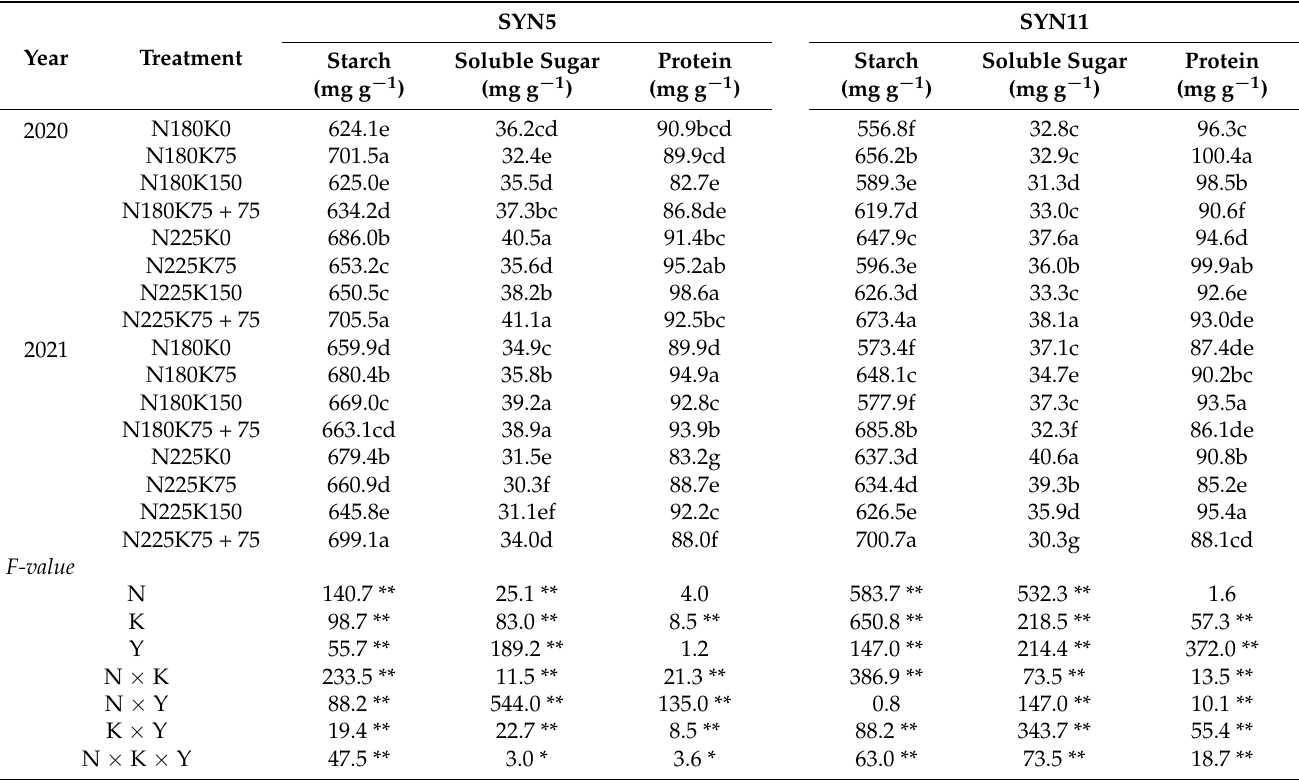
Table 2. Interactive effects of nitrogen and potassium on grain components of waxy